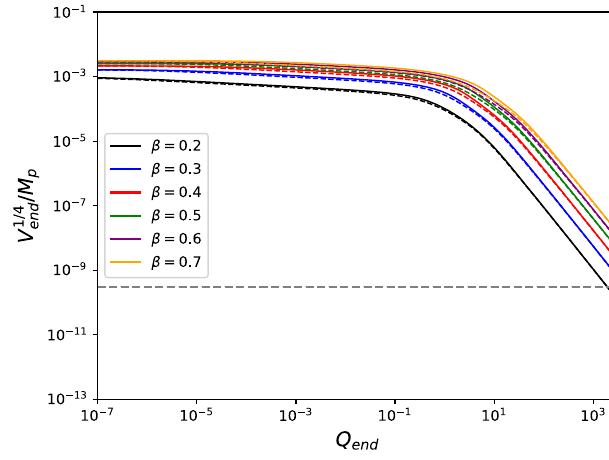
Fig. 5 The ratio M p | V ,φ | / V , the field excursion Δφ (left panel) and / 4 / M the potential V 1 p (right panel) as a function of Q (cid:10) for the end